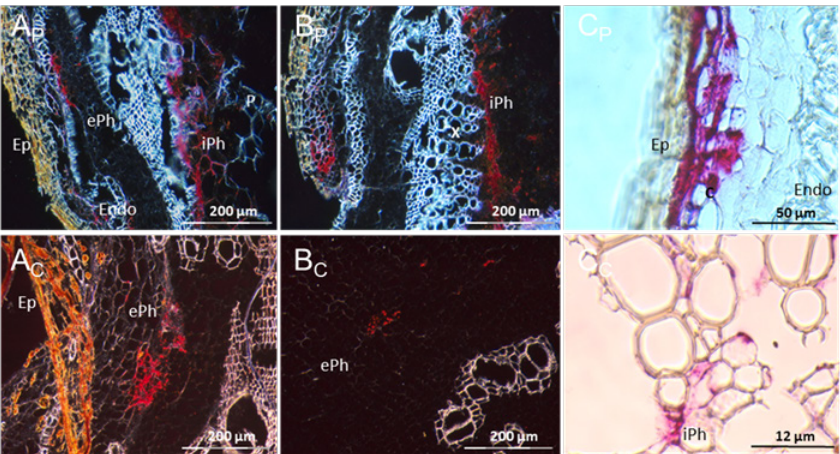
Figure 13. Distribution of UCBSV-Ke125 RNA in cross sections of DSC 167 stem tissues. Cross sec- tions were subjected to RNAscope ® ISH using an UCBSV-Ke125 probe, showing red signals indicat- ing the presence of the viral RNA in phloem cells and non-phloem cells. ( Ap – Cp ) Sections prepared from samples embedded in paraffin. ( Ac – Cc ) Tissues subjected to cryo-sectioning. X, xylem; P, pa- renchyma; C, cortex; ePh, external phloem; iPh, inner phloem; Ep, epidermis; Endo, endodermis.